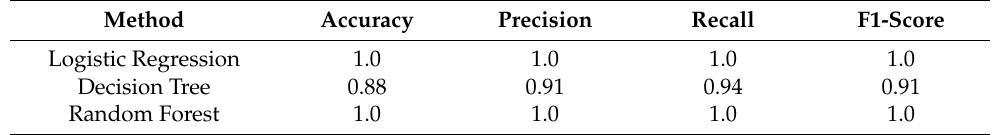
Table 7. Classification report for the supervised methods—pressure